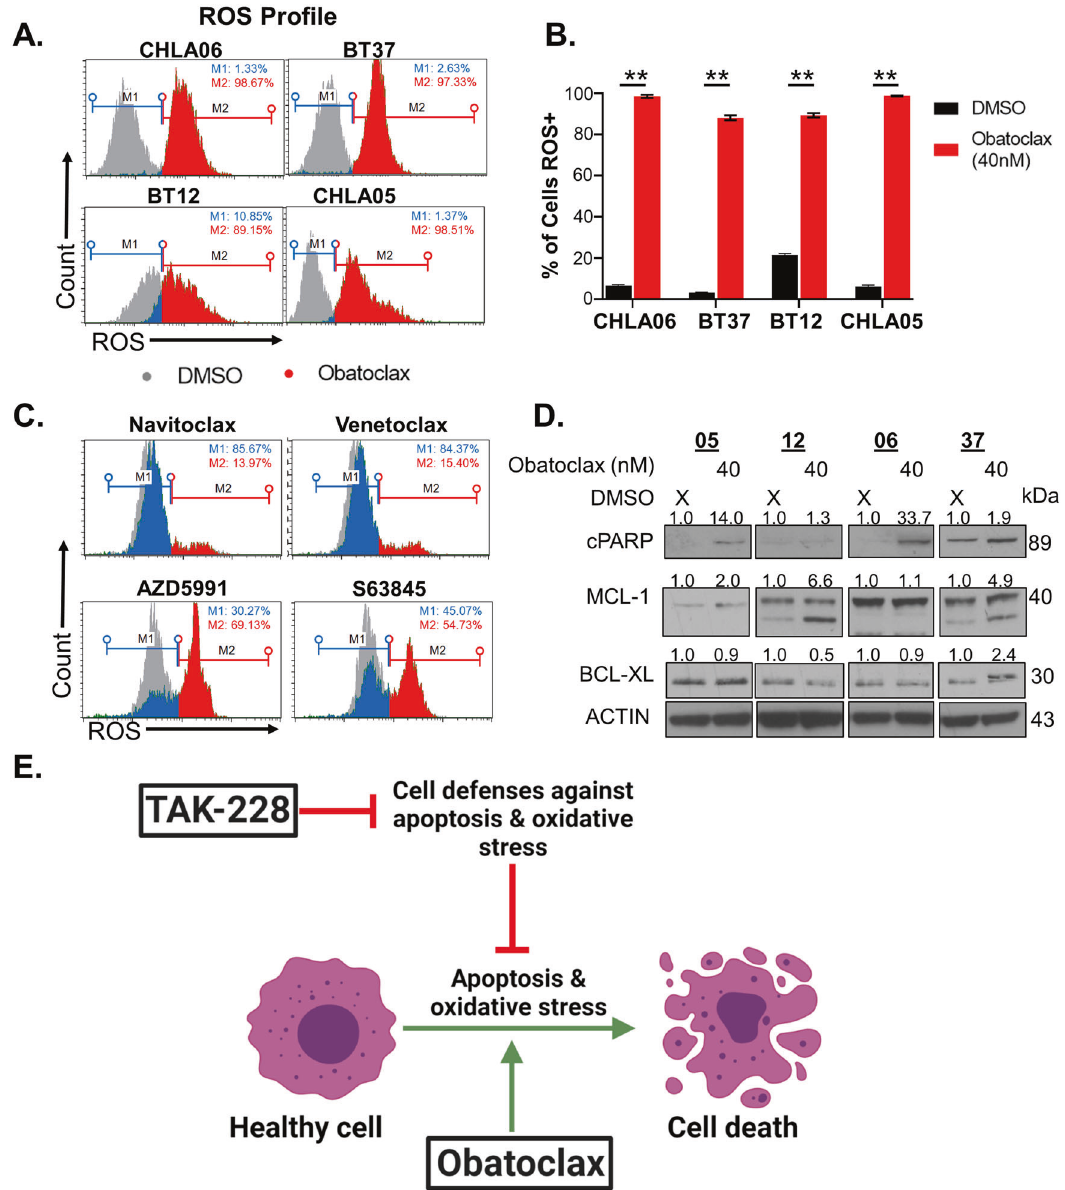
Fig. 3 Obatoclax is a potent inducer of apoptosis and oxidative stress in AT/RT. A MUSE oxidative stress assay. M1 represents reactive oxygen species (ROS) negative cells, M2 ROS-positive cells. DMSO-treated cells shaded in gray, Obatoclax ROS negative (blue), ROS positive (red). B Graphs illustrating percent of cells ROS positive. The results are presented as the mean + / − SEM. **Indicates p < 0.005, t- test. C Muse oxidative stress assay. CHLA06 cells were treated with the IC 50 dose of the BH3 mimetics Navitoclax and Venetoclax, and the MCL-1 inhibitors AZD5991 and S63845. ROS-negative cells (blue), ROS- positive cells (red). DMSO-treated cells shaded in gray. D Western blot 24 h after Obatoclax treatment in 4 AT/RT cell lines probing for cleaved PARP (cPARP) and the anti-apoptotic proteins MCL-1 and BCL-xL. Numbers above blots represent quanti fi cation of protein expression normalized to ACTIN. E Diagram illustrating complementary mechanisms of action between TAK-228 and Obatoclax. TAK-228 interferes with cell defenses against apoptosis and oxidative stress, while Obatoclax induces apoptosis and oxidative stress in